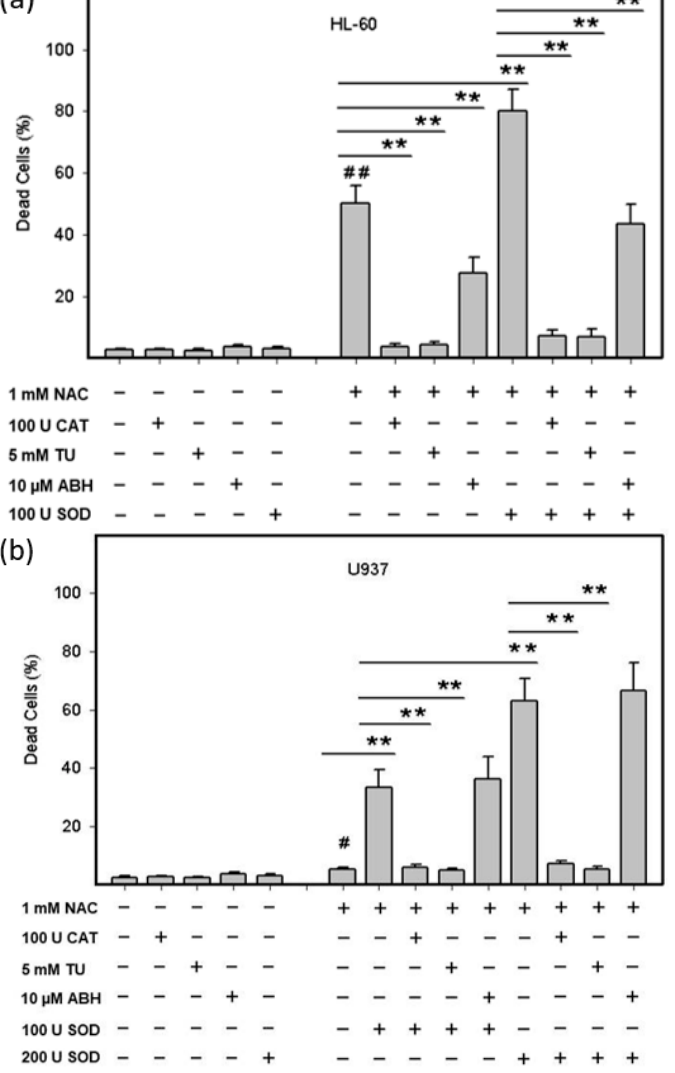
Figure 3. Effect of ROS modulators on viability of NAC treated HL-60 and U937 cells. Cells were treated with NAC or with NAC in combinations with ROS modulators as indicated. After 24 h incubation, the number of dead cells was determined using the trypan blue dye exclusion assay. ( a ) HL-60 cells. ( b ) U937 cells. Columns represent the mean from three independent experiments with standard errors. # / ## denotes significant/very significant difference in the number of dead cells ( p < 0.05/ p < 0.01) between the NAC treated and untreated (control) cells. ** denotes very significant difference in the number of dead cells ( p < 0.01) between the indicated